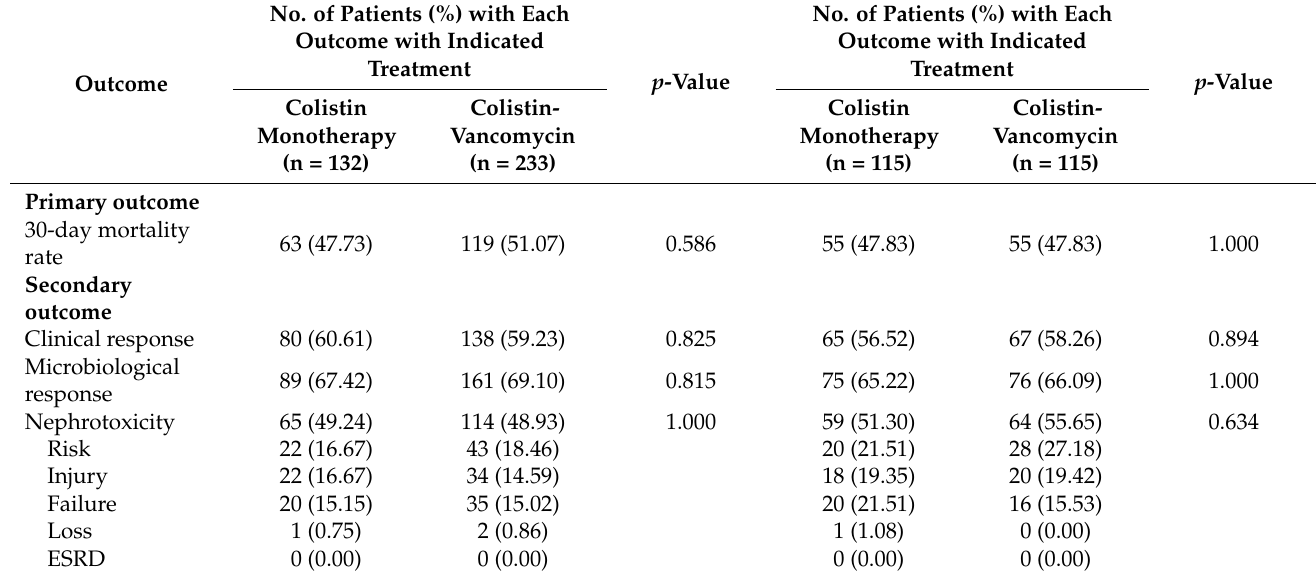
Figure 1. Distribution of propensity scores. ( A ) Propensity score before matching and ( B ) propensity score after matching. 3.1. Patient Outcomes before Propensity Scoring Match From a crude comparison of the 30-day mortality rate, it can be determined that 47.73% of patients were in the colistin alone and 51.07% in colistin plus vancomycin groups, respectively, ( p = 0.586). The rate of clinical response observed was 60.61% of the patients in the colistin alone and 59.23% in colistin plus vancomycin groups, respectively ( p = 0.825). The rate of microbiological response observed was 67.42% of the patients in the colistin alone and 69.10% in colistin plus vancomycin groups, respectively ( p = 0.815). Moreover, the rate of nephrotoxicity according to the RIFLE criteria was 49.24% for the colistin monotherapy and 48.93% in colistin plus vancomycin groups, respectively ( p = 1.000). The analysis for crude outcomes is shown in Table 2. Table 2. Crude outcomes, toxicity and mortality rates in patients received colistin monotherapy compared to colistin- vancomycin combination